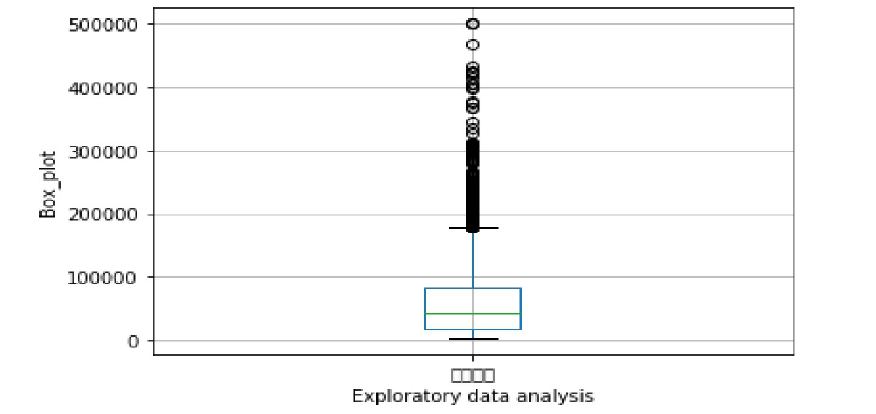
Fig 14. Exploratory data analysis for loan amount (A10).